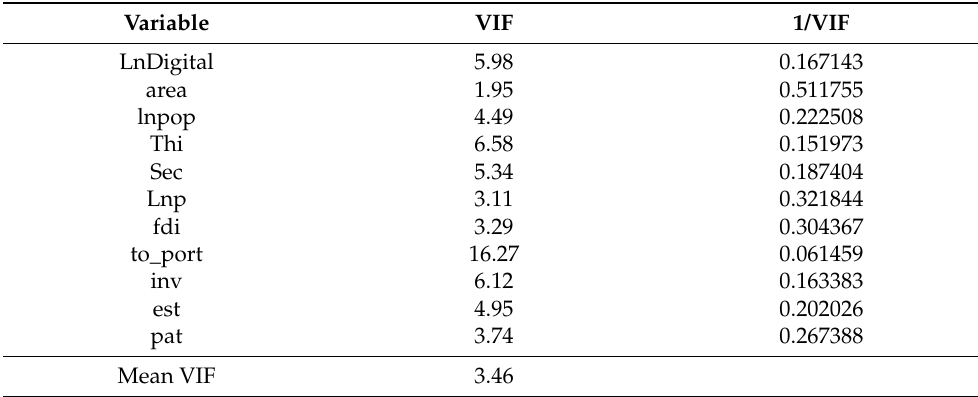
Table 5. Descriptive Statistics of the Explanatory